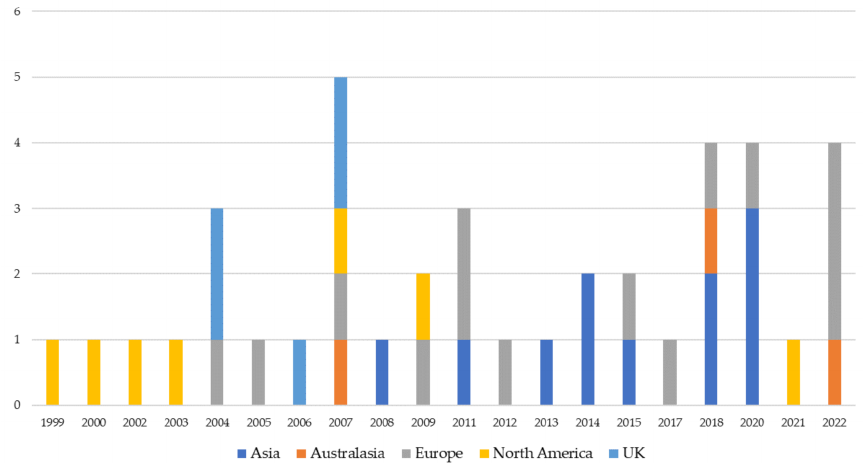
Figure 5. Distribution of papers by country areas and